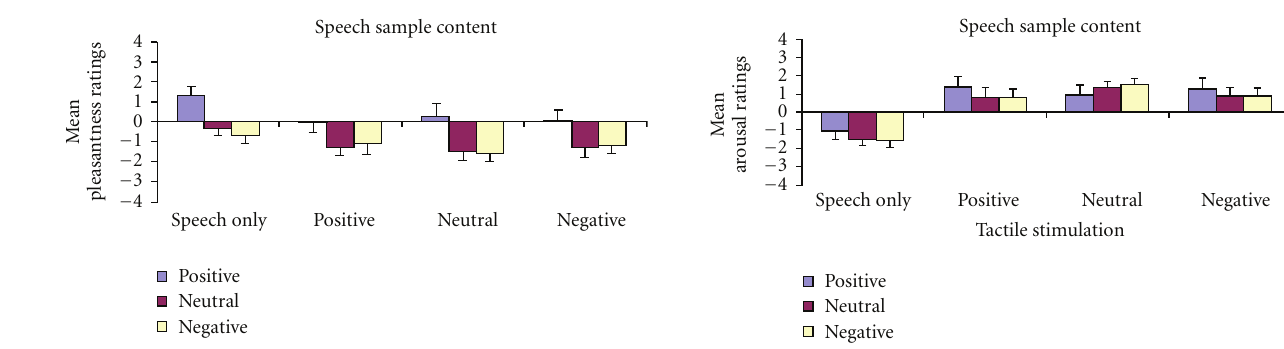
Figure 8: Means and SEMs for the ratings of the stimulus arousal.